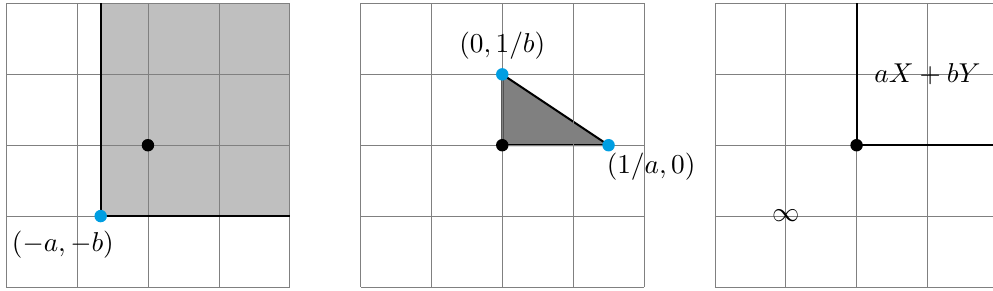
Figure 6 . The polyhedron P = ∞P 1 + a P 2 + b P 3 , its dual P ◦ , and the piecewise linear function −∞ min(0 , X, Y ) − a min(0 , − X ) + b min(0 , − Y )